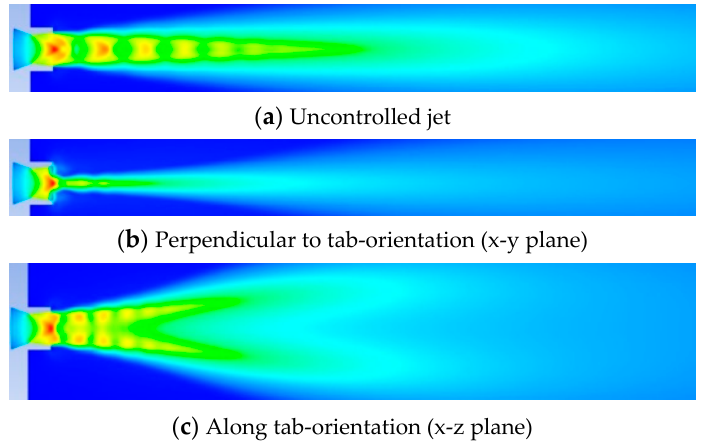
Figure 24. Mach contours of uncontrolled and controlled jets at NPR 4 (overexpansion).